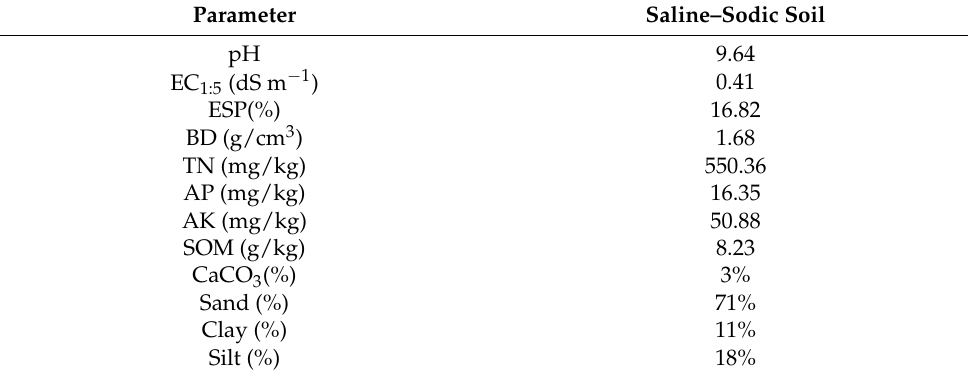
Table 2. Physicochemical characteristics of saline–sodic